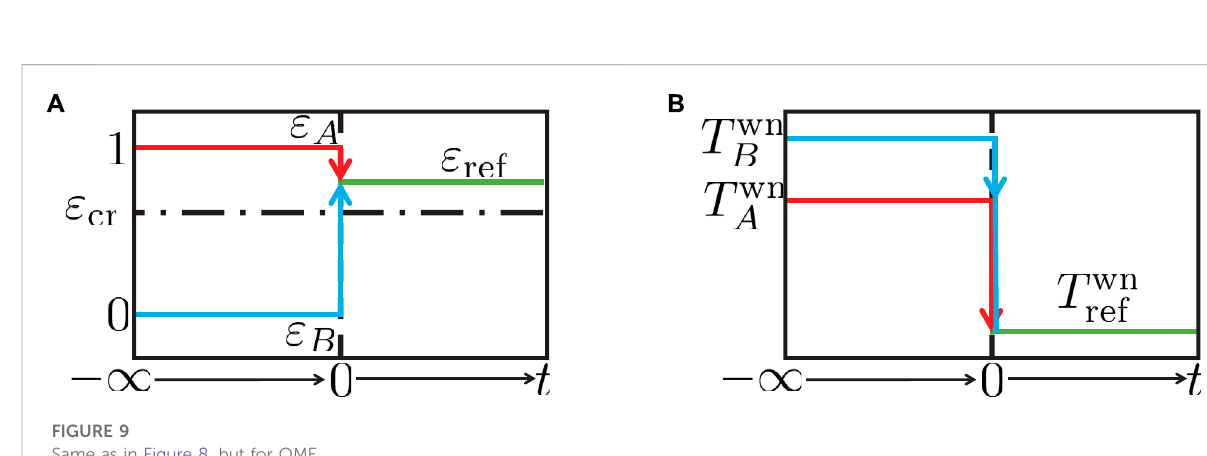
FIGURE 9 Same as in Figure 8, but for OME.